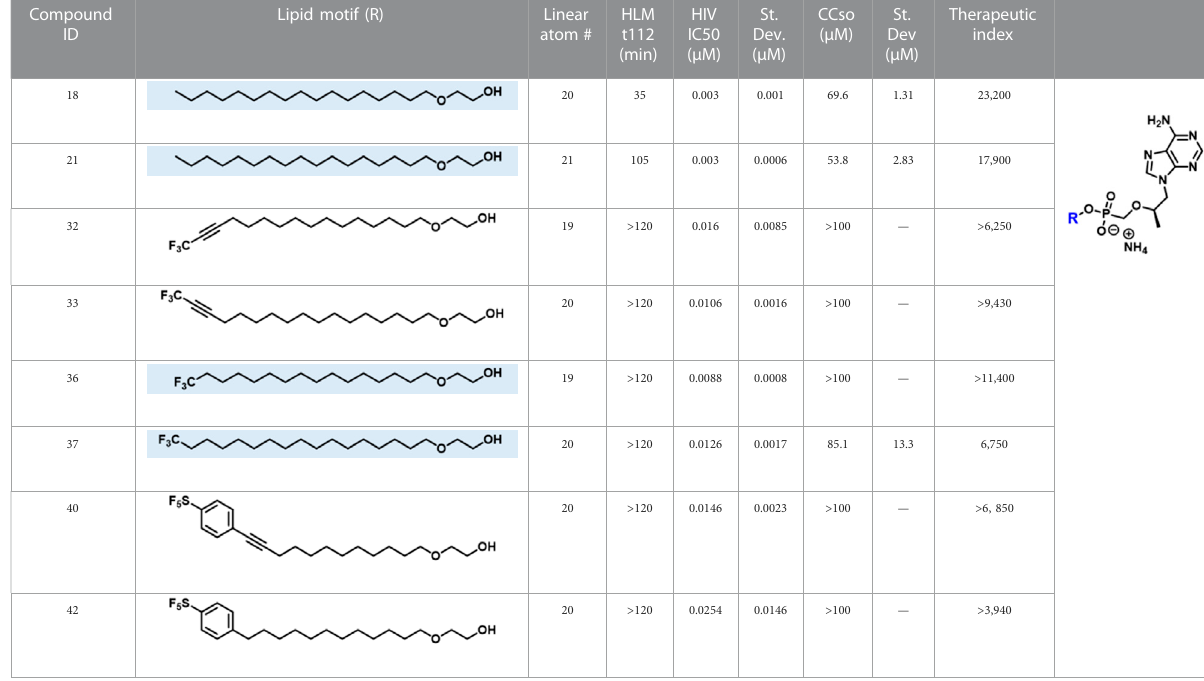
TABLE 3 In vitro activity pro fi les of oxyethyl- linked lipid prodrugs of TFV featuring chain length tweaks and metabolically stable lipid termini. All HIV and cytotoxicity results represent data generated with compounds formulated as HSA complexes in 5:1 M ratios. Nd = not determined. Compound Lipid motif ID